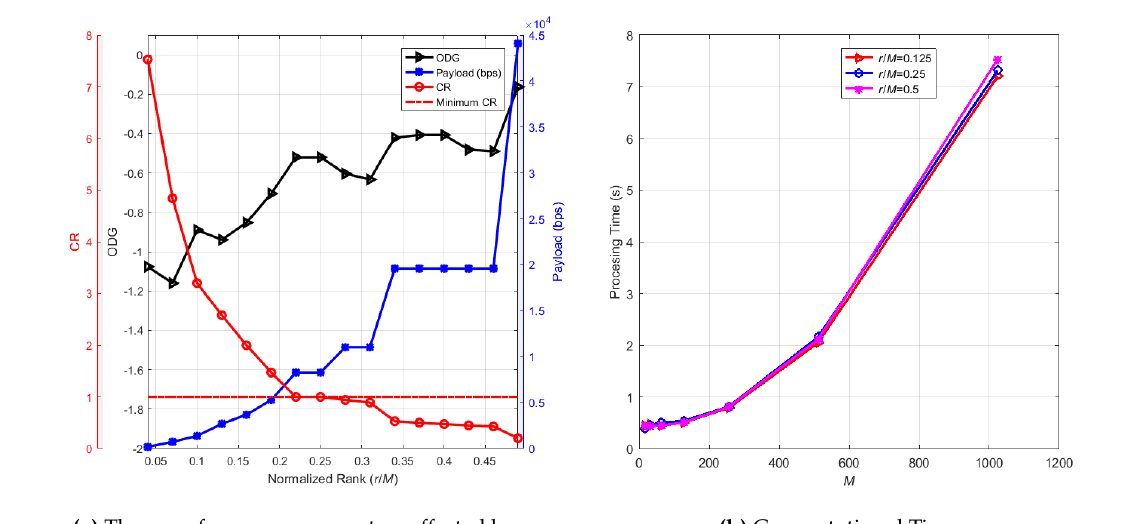
Figure 5. Three performance parameters affected by r / M and computational